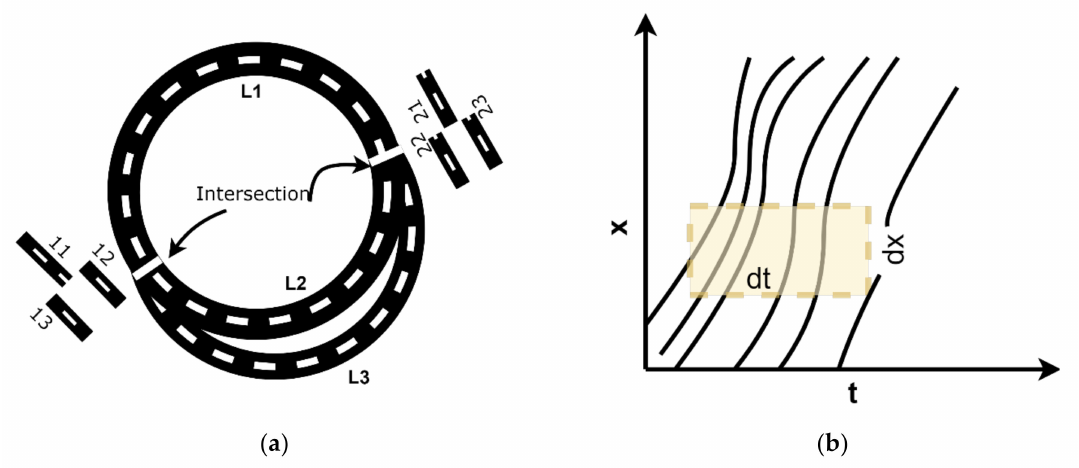
Figure 3. ( a ) Traffic network with three links and two intersection points; ( b ) the trajectories of the vehicles and a discrete area to estimate the traffic